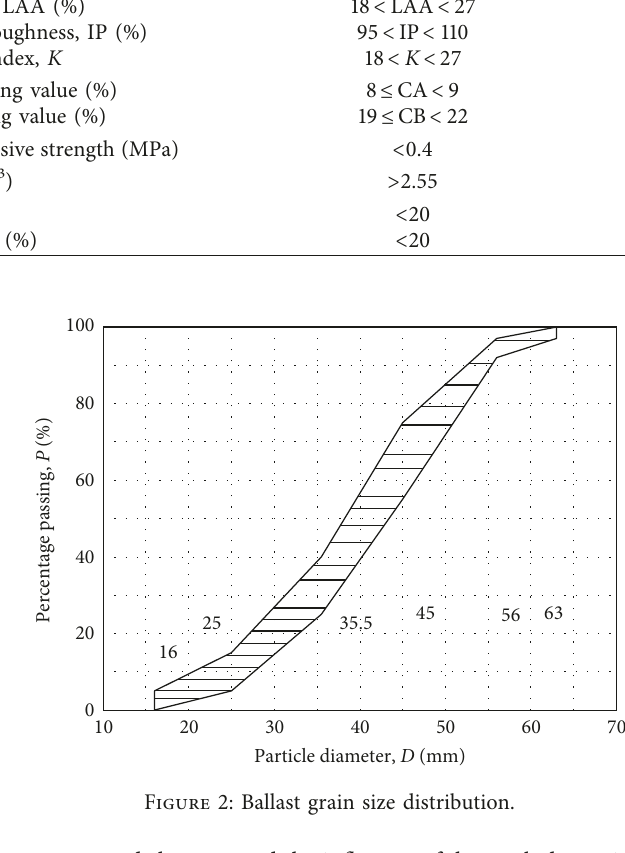
Figure 1: Outline of full-scale track model: (a) section size of the ballast bed and (b) model track panel. Table 1: Physical and durable attributes of Class I ballast materials. Parameters Characteristics of test results